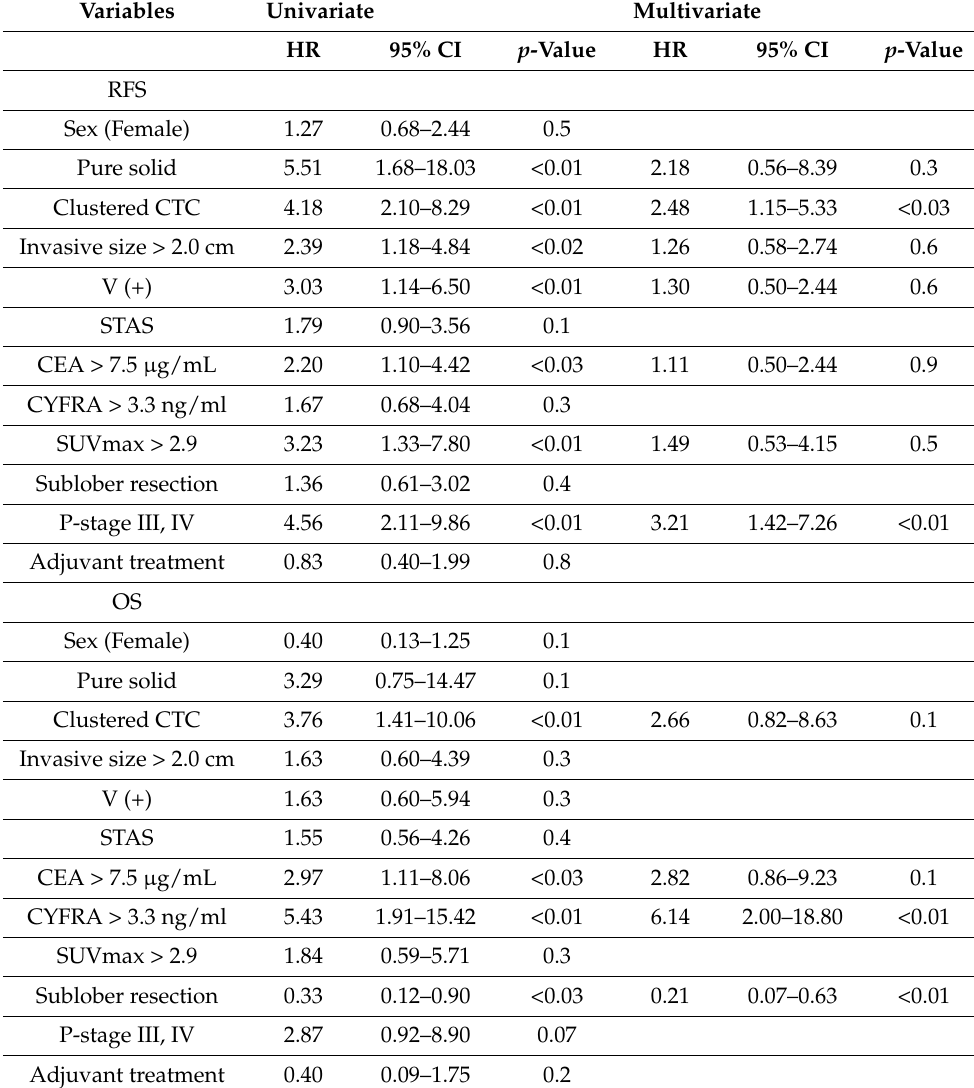
Table 4. Cox proportional hazard model